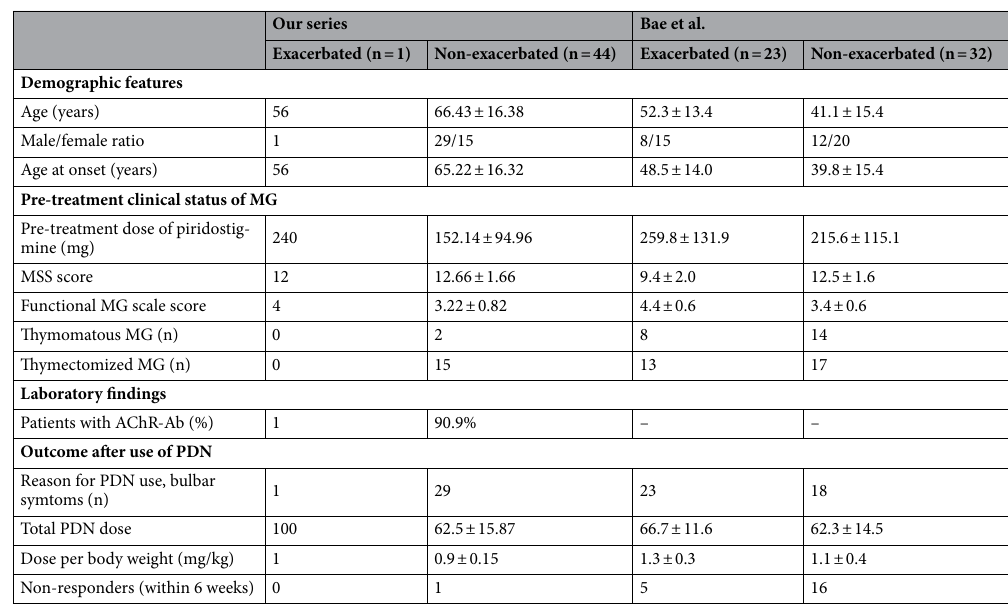
Table 3. Comparison between the steroid exacerbated and non-exacerbated myasthenia gravis groups between our series and Bae et al. series.